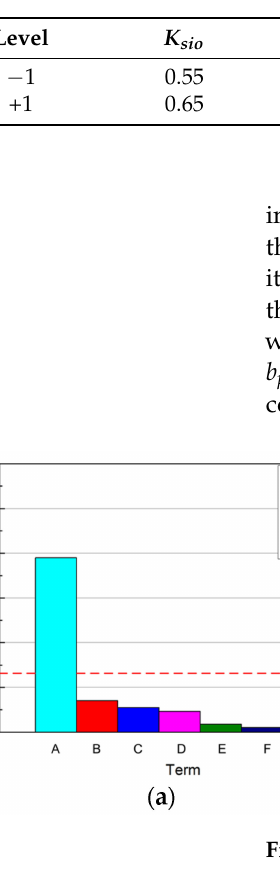
Table 3. Variable ranges and levels of 1/8 FFD.